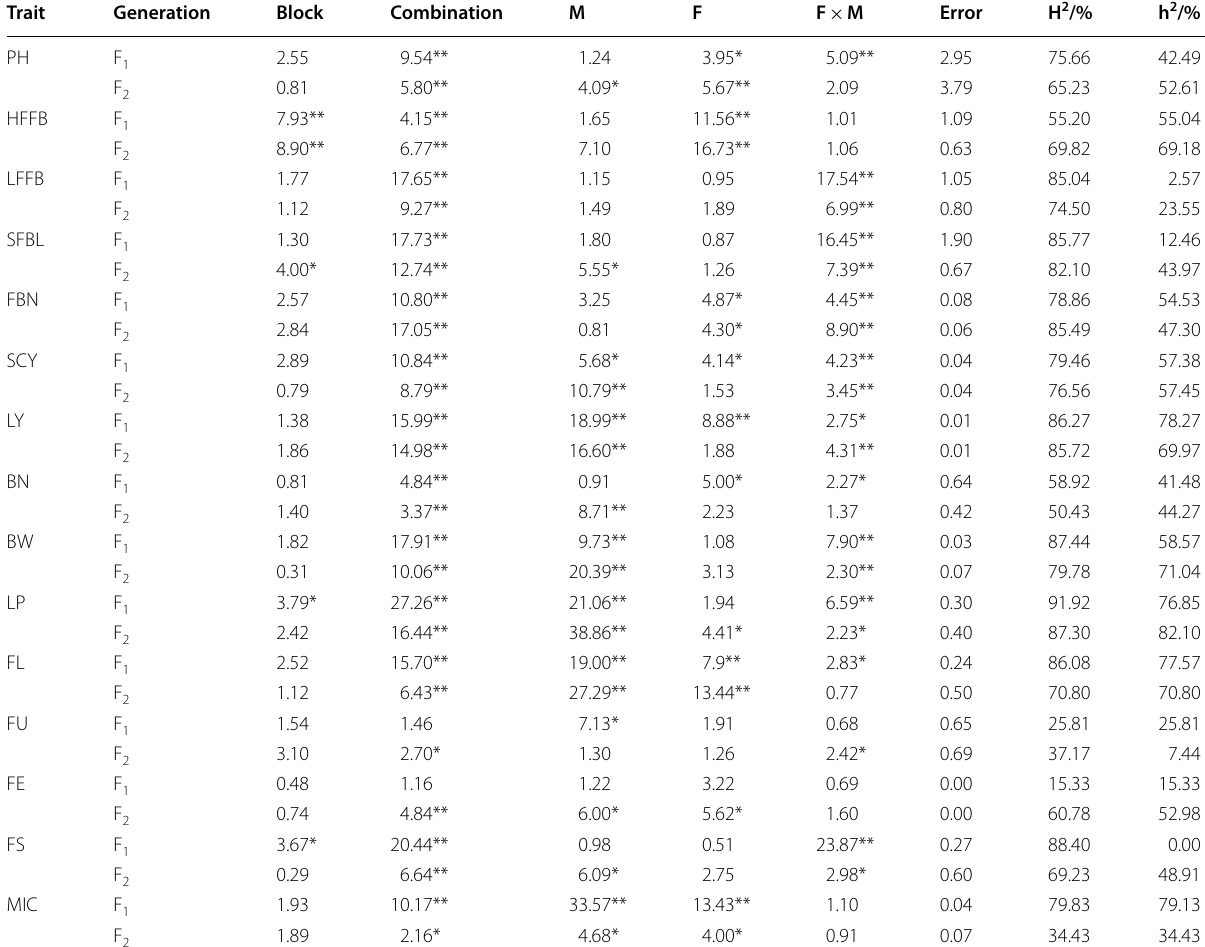
F female, M male *and ** denote significant differences at 0.05 and 0.01 levels, respectively